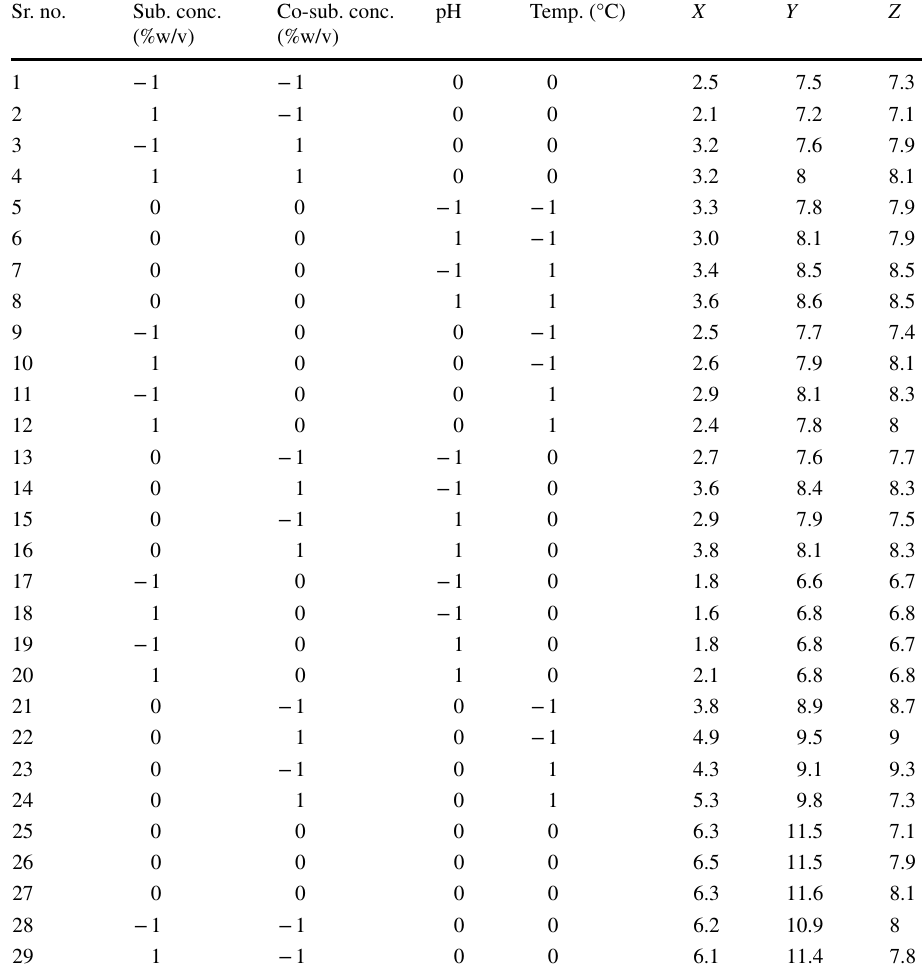
Table 1 Experimental design in terms of coded factors and results of the Box–Behnken